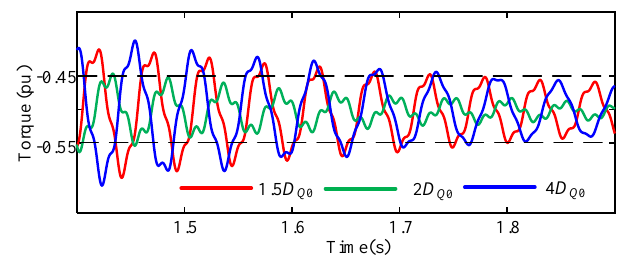
Figure 18. Enlarged waveform of electromagnetic torque. Table 2. SSR damping time.